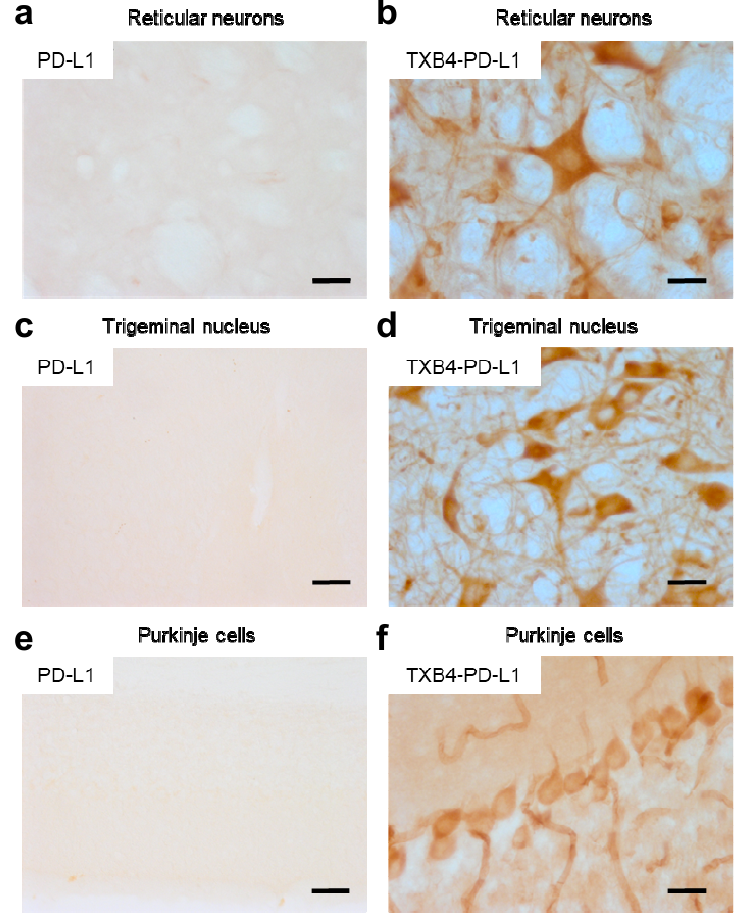
Figure 6. IHC assessment of antibody delivery to the brain parenchyma using the TXB4 shuttle. Mice were dosed with either the TXB4-PD-L1 fusion or unmodified antibody at 25 nmol/kg, IV and brains were collected following cardiac perfusion 18 h post injection ( n = 2). Brain sections were stained for the presence of exogenous antibodies via IHC and images were collected from representative regions for comparison. Sections taken from the thalamus showed the distribution of the ( a ) PD-L1 antibody versus ( b ) TXB4-PD-L1. Prominent neuronal staining was only observed with the antibody fused to the shuttle. Pronounced TXB4-PD-L1 staining was seen in trigeminal neurons in the midbrain ( d ) and Purkinje cells in cerebellum ( f ), where diffuse parenchymal staining and BCEC staining were clearly distinguishable; PD-L1 antibody showed no staining in corresponding sections ( c , e ). Scale bars at 50 µ